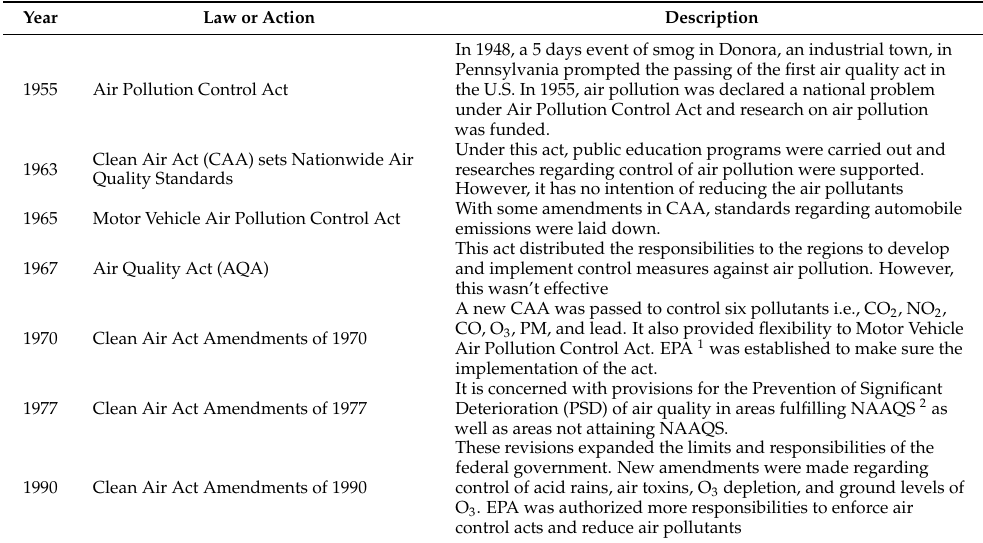
Table 6. Evolution of U.S. legislation on air pollution